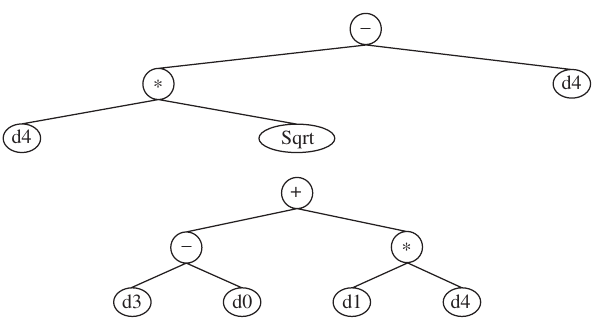
Figure 8 Expression tree